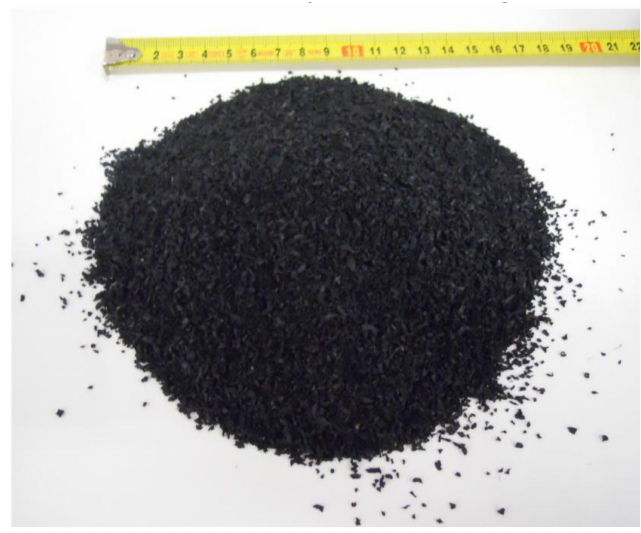
Figure 1. Waste rubber used in the